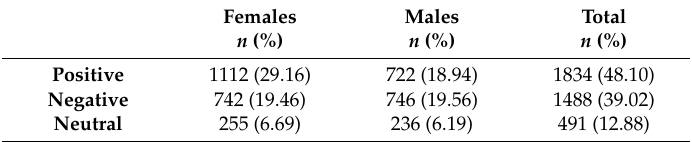
Table 3. Association between sex and family influence on the decision to own a